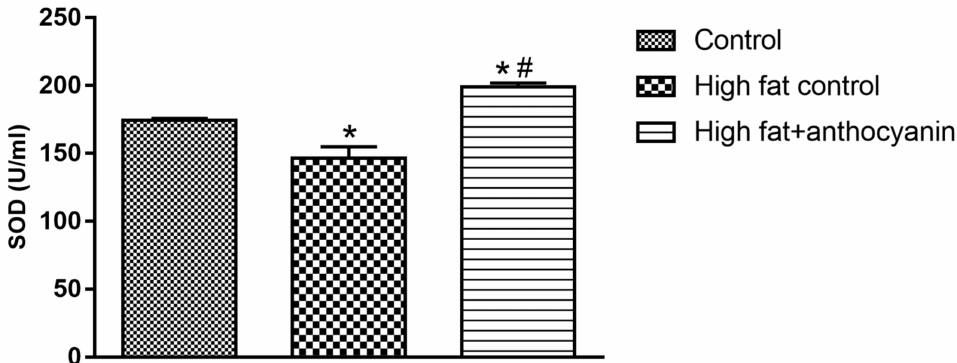
Figure 7. E ff ect of chronic anthocyanin treatment on the plasma levels of SOD. The * indicates a significant di ff erence ( p < 0.05) from the control group. The # indicates a significant di ff erence ( p < 0.05) between the high fat control and the high fat + anthocyanin groups.